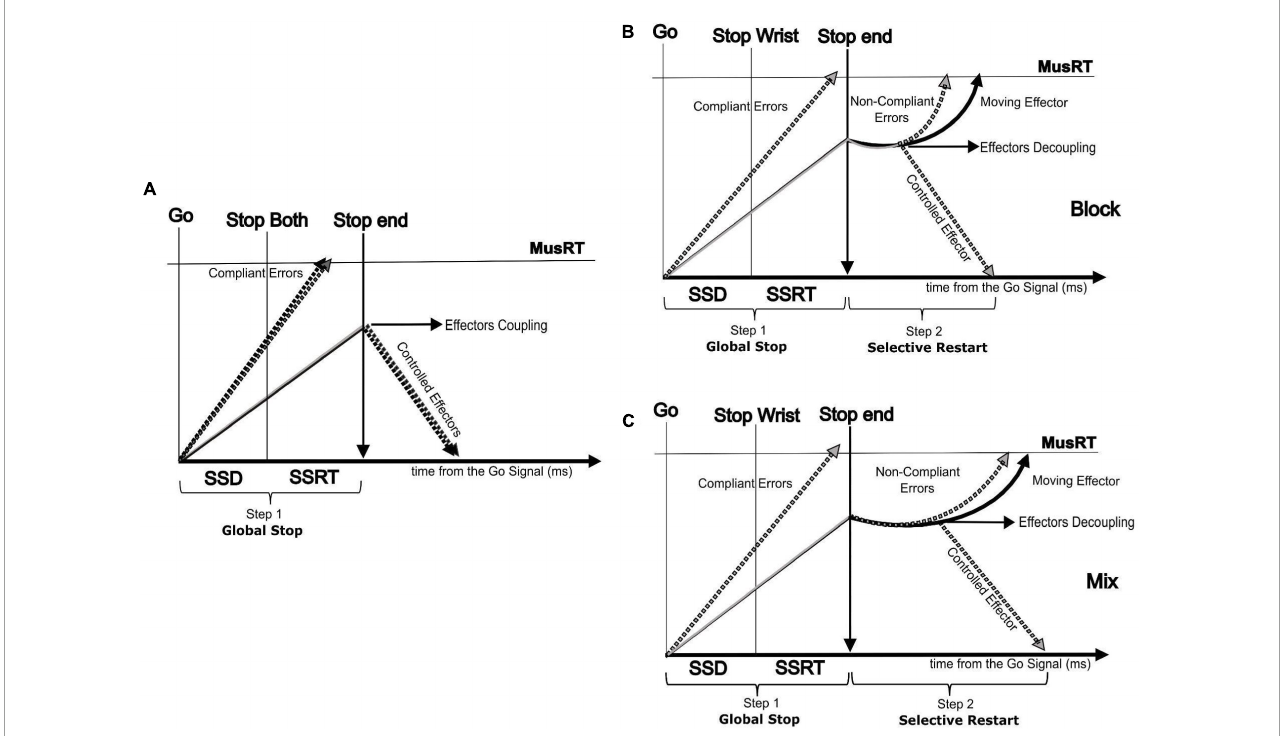
FIGURE6 Two step (Restart) model showing the paired run of the two effectors followed by an effector decoupling process in the second step (selective restart). (A) Non-selective Stop version (Stop Both) showing the run of the two effectors followed by a global effector coupled inhibition process (first step); selective Stop version (only Stop Wrist shown) showing the run of the two effectors by an effector decoupling process in the second step (selective restart of only the foot) in the Block condition (B) and Mix condition (C)